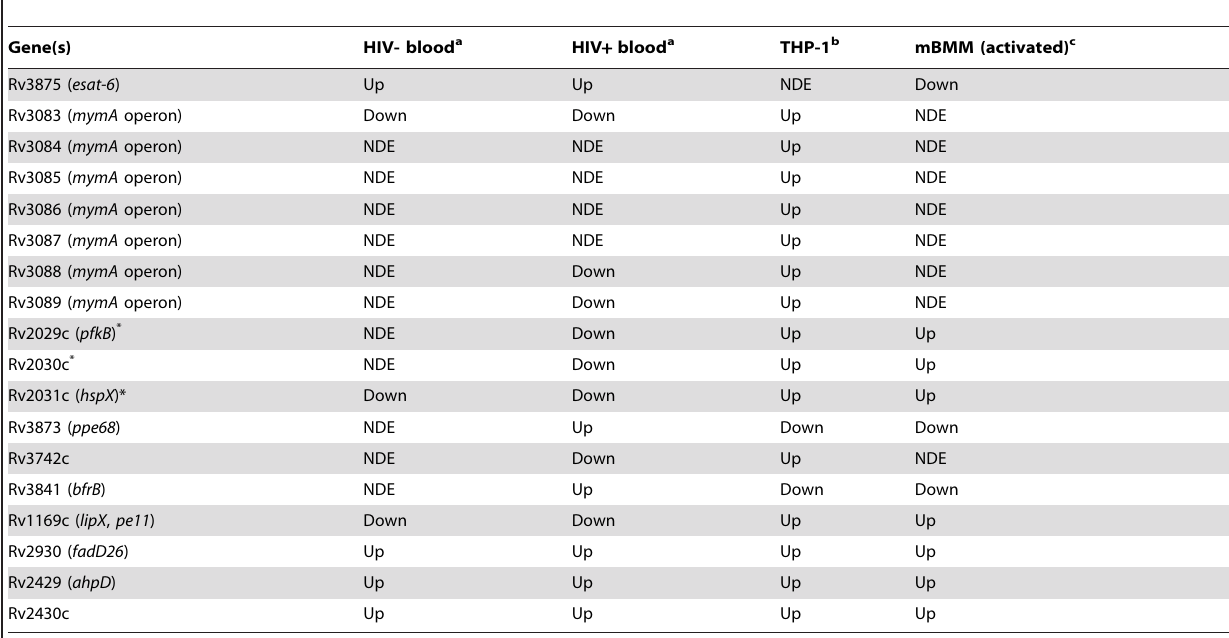
Table 2. Comparison of M. tb genes differentially expressed in HIV- donor and/or HIV + patient whole blood with corresponding M. tb genes in the intra-macrophage environment from two published